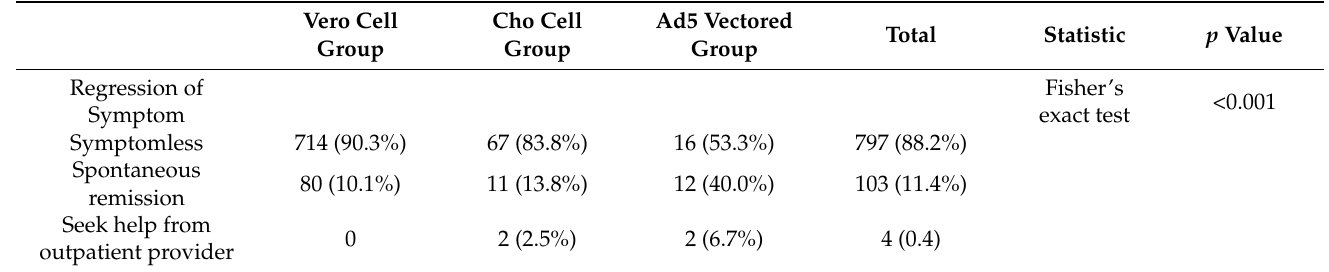
Table 2. Medical attention received by study participants after receiving one of three types of COVID-19